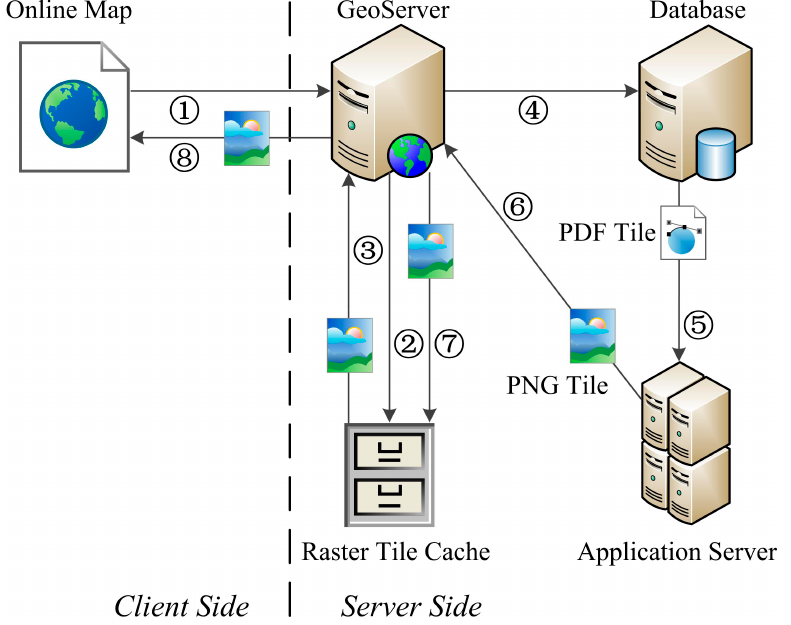
Figure 18. Online map system architecture base on raster tile service. Numbers 1, 2 and 4 denote the process of data request. Numbers 3, 5, 6, 7 and 8 denote the process of data transmission.